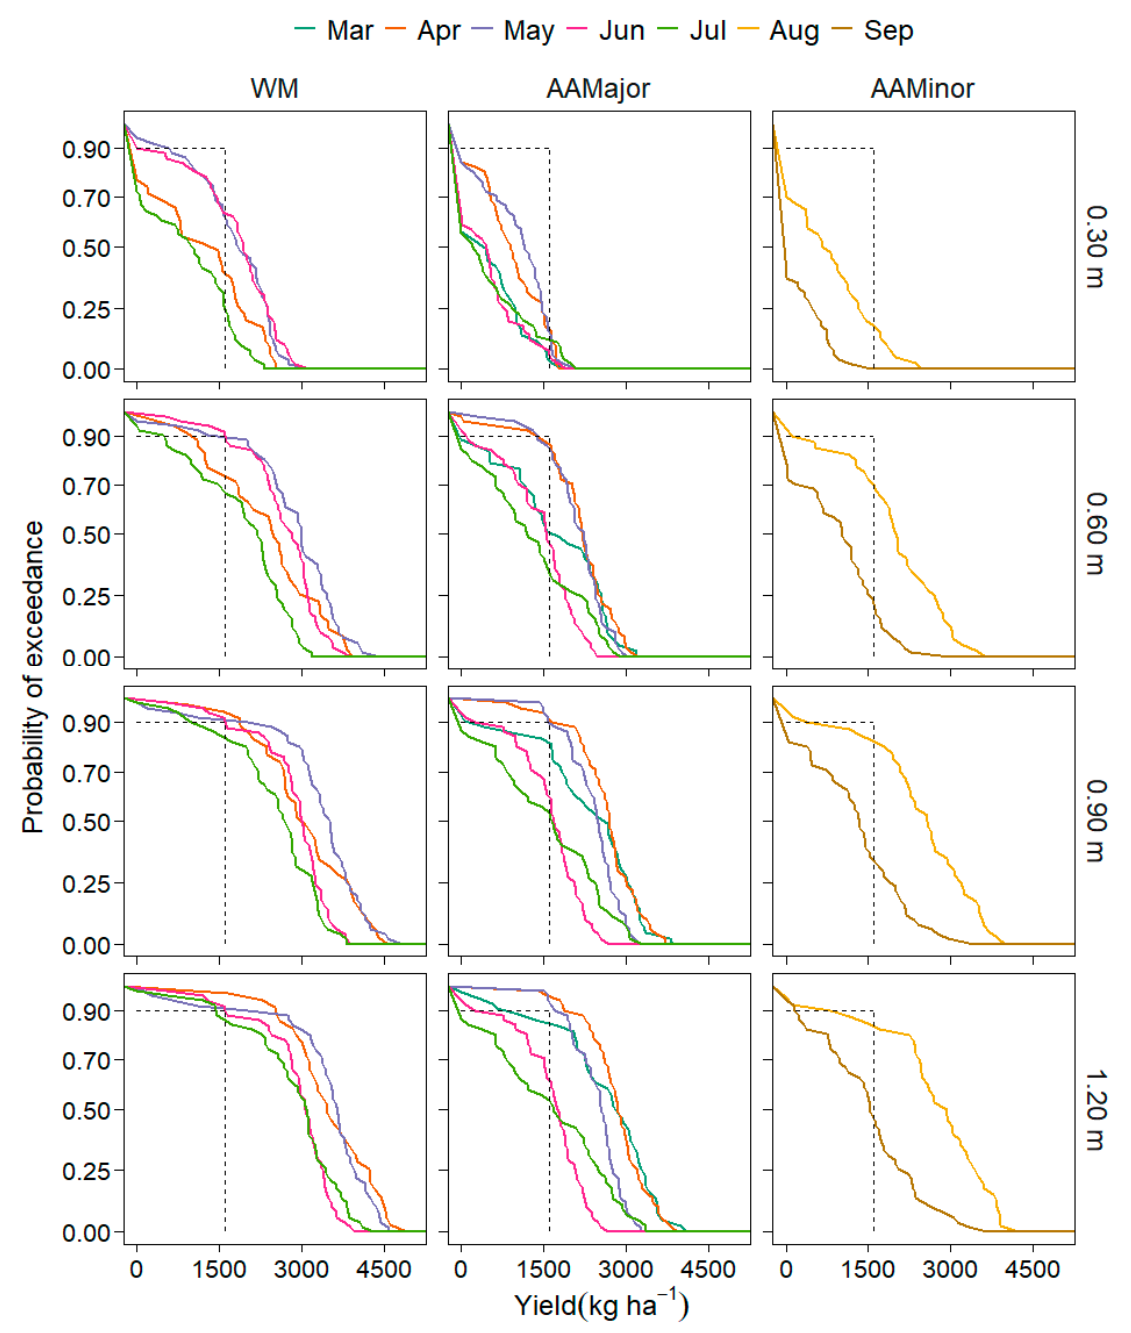
Figure 8. Simulated grain yield of maize fertilized 75 kg N rate, soil root penetration constrained at 30, 60, 90 and 1.20 m, and various sowing windows for West Mamprusi (WM), major season Atebubu-Amantin (AAMajor) and minor season Atebubu-Amantin (AAMinor). The vertical broken line denotes average measured farmers’ yield for the sites. The horizontal broken line represents the 90% probability that observed farmers’ yield will be equaled or exceeded.